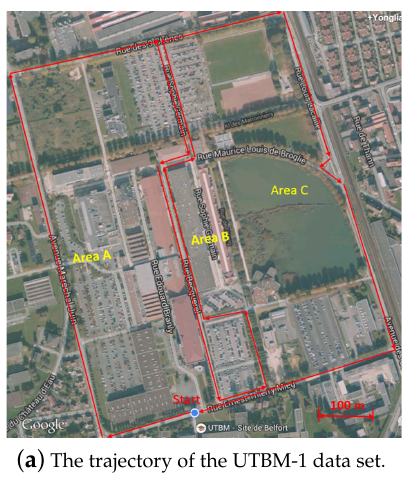
Figure 5. The trajectory of the UTBM-1 data set and its representative images: ( a ) The trajectory acrosses forest, city, and parking areas. ( b ) Three representative examples of appearance and shadow variations. The images in each row are taken in the same place at different times (interval time of one week).